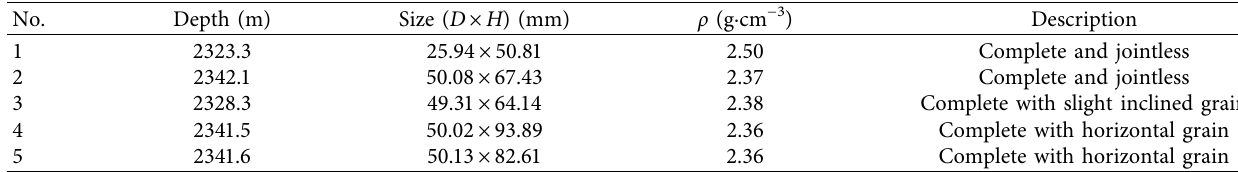
Table 1: Basic parameters of origin rocks for triaxial compression.